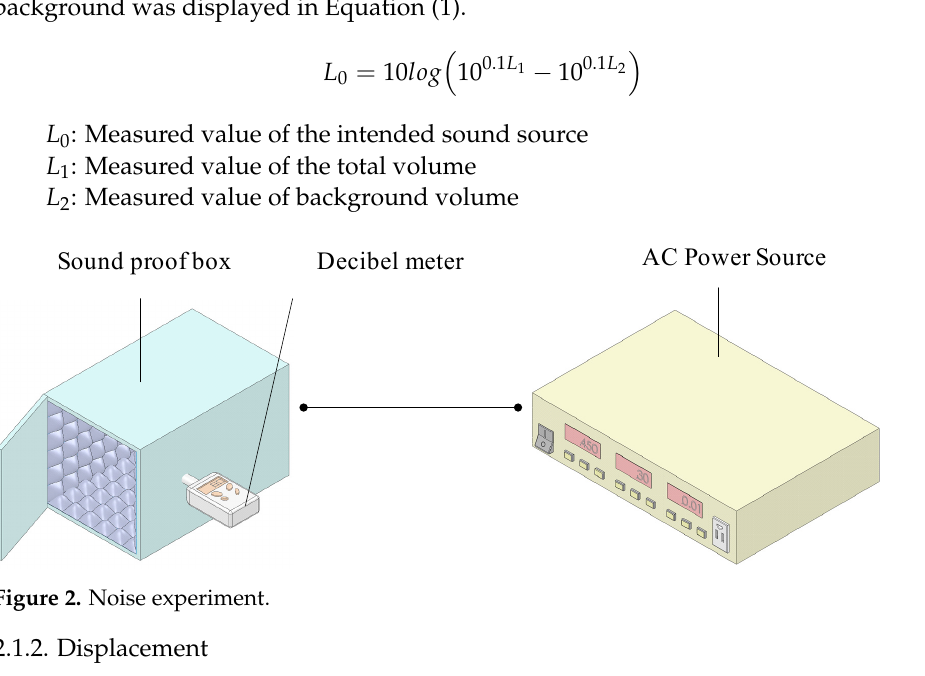
Figure 2. Noise experiment.